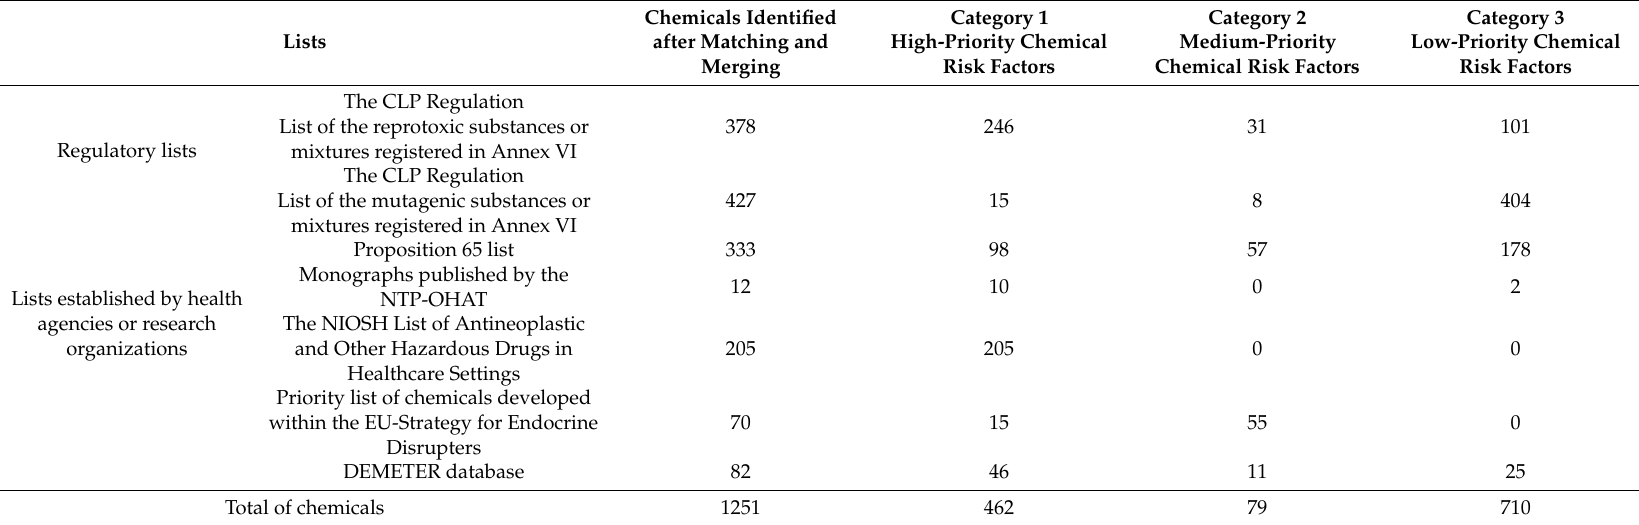
Table 1. Number of environmental reproductive hazards registered on each classification, prioritized according to our method.